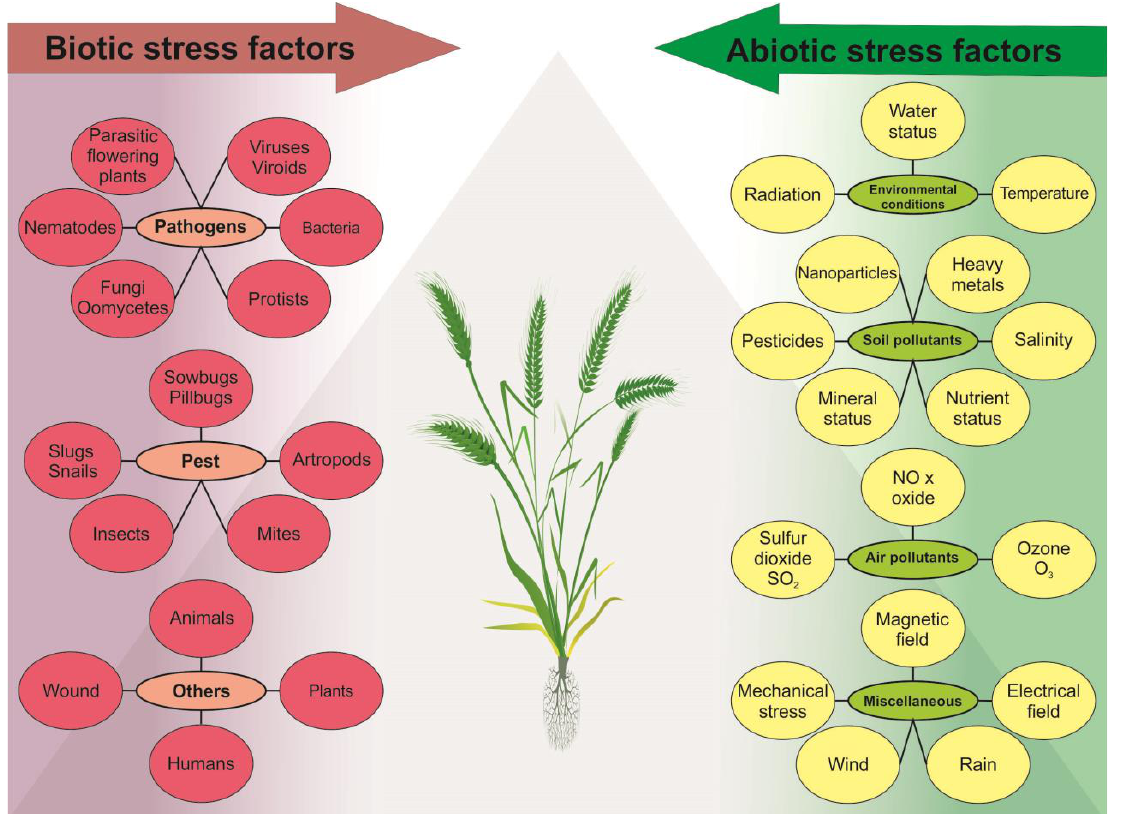
Figure 1. Plants can be subjected to stress due to both biotic factors, such as pathogens, pests, and direct animal and human influences, and abiotic factors, such as diverse climatic changes, soil and air pollution, and magnetic fields. These stressors can act individually, simultaneously, or in various combinations, and disrupt plant homeostasis, impede growth, and impact development in wild populations and cultivated field